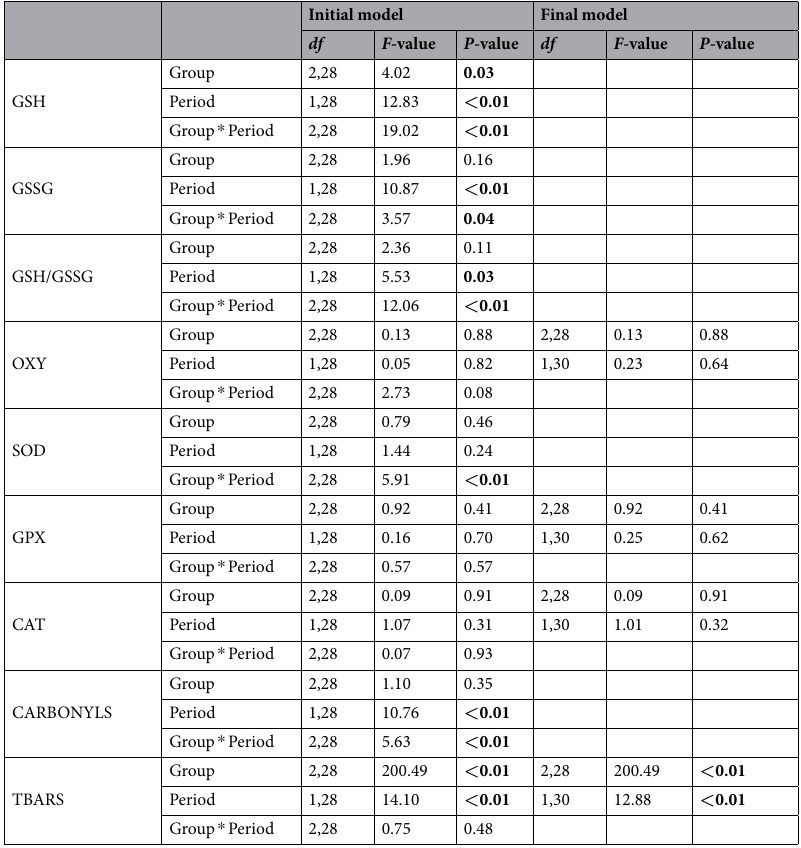
Table 1. Full and best fit linear mixed models of nine biomarkers of non-enzymatic antioxidants, enzymatic antioxidant activity, and oxidative damage, respectively. Significant P-values are bolded. When a final model is not shown, initial and final models matched.